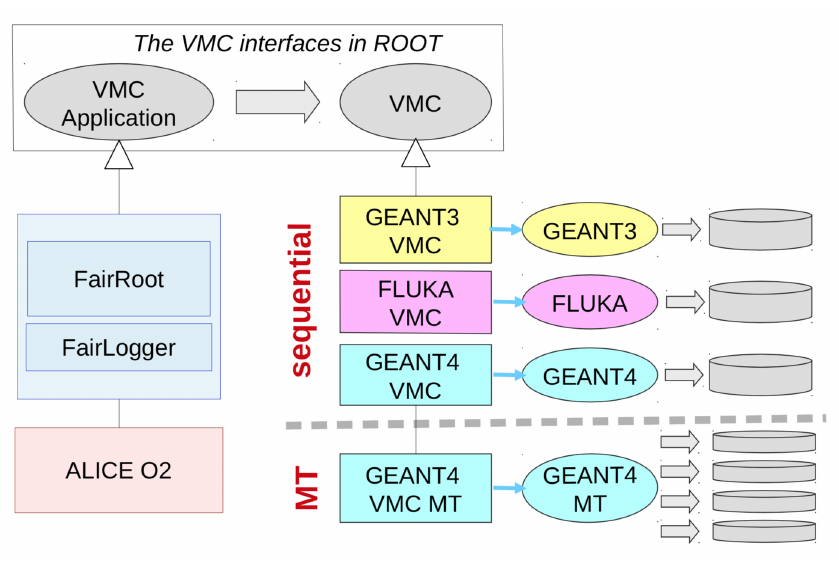
Figure 1. The VMC context in O2